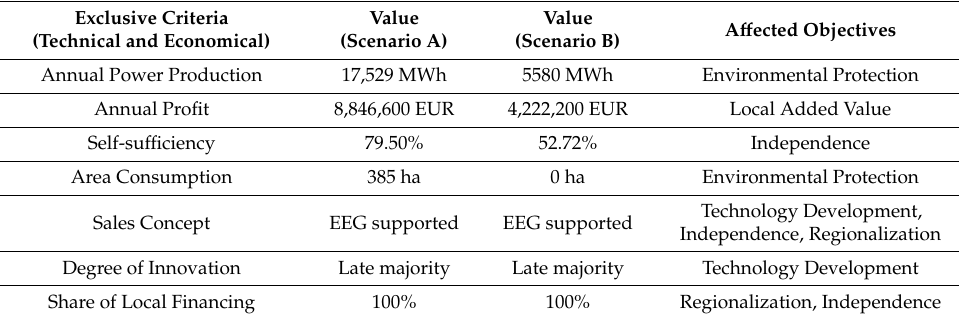
Table A2. Exclusive project criteria and parameters.